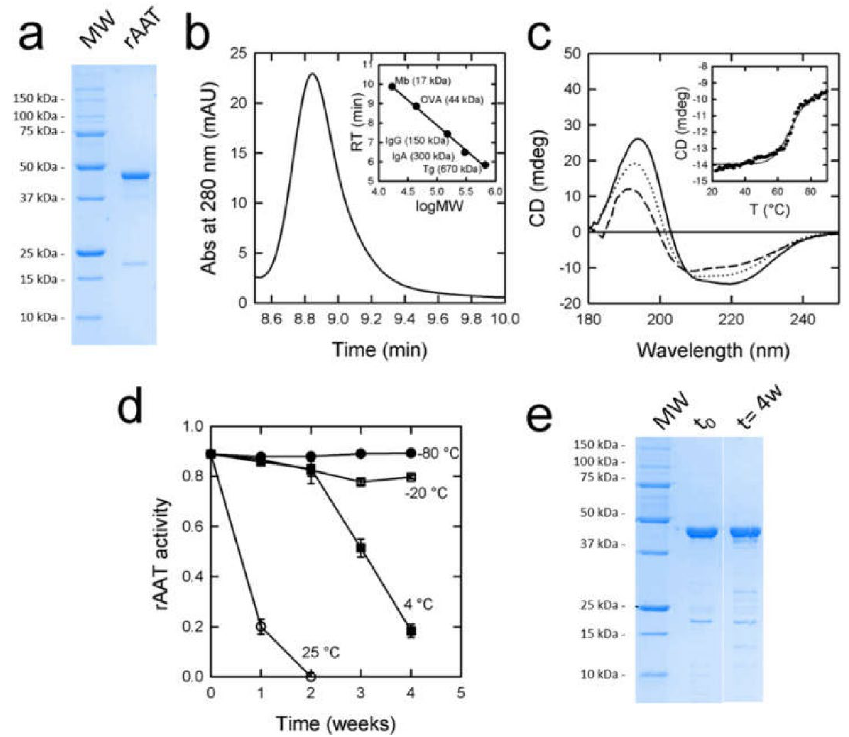
Figure 1. ( a ) Coomassie blue-stained SDS-PAGE gels of purified rAAT. ( b ) SEC chromatogram and calibration curve (inset). ( c ) Circular dichroism spectra of rAAT before heating (solid line), upon incubation at 90 °C (dashed line), and after a slow return to 20 °C (dotted line). Inset: Thermal ramp experiment between 20 and 90 °C; the black line is the fitting obtained with the CalFitter algorithm. ( d ) Antielastase activity of rAAT sampled over time upon storage at −80 °C, −20 °C, 4 °C, and 25 °C. Data are shown as mean ± SE. ( e ) SDS-PAGE of rAAT solution before (t0) and after incubation at 4 °C for 4 weeks (t = 4w).